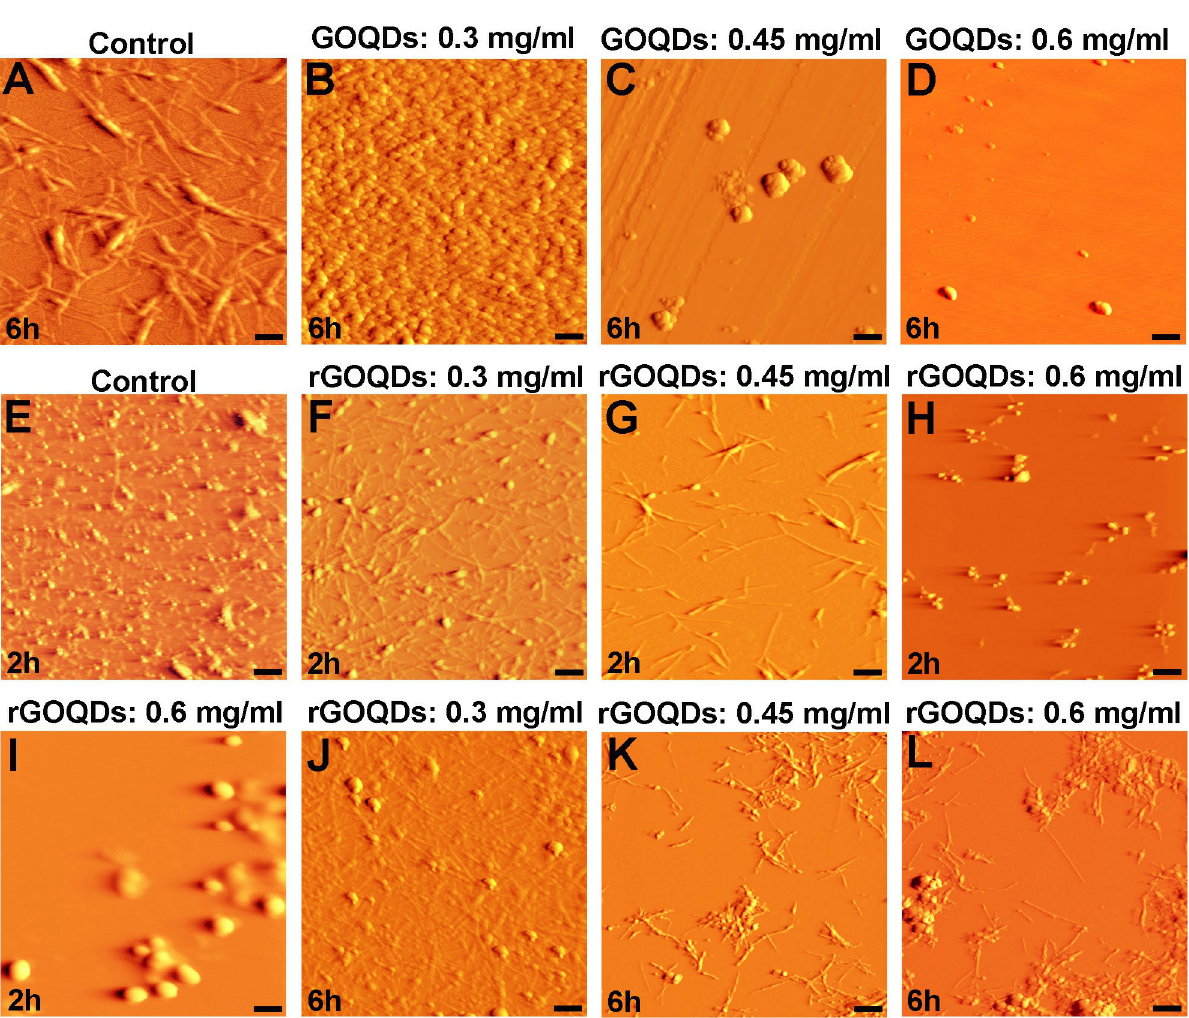
Fig 6. AFM images of bovine insulin incubated with different concentrations of GOQDs or rGOQDs. Protein samples (100 μ M) were incubated in H 2 O/HCl solution (pH 1.5) at 57 � C either alone or with various concentrations of GOQDs or rGOQDs. (I) An enlarged view of (H). The scale bar is 100 nm in (I) and 500 nm in other